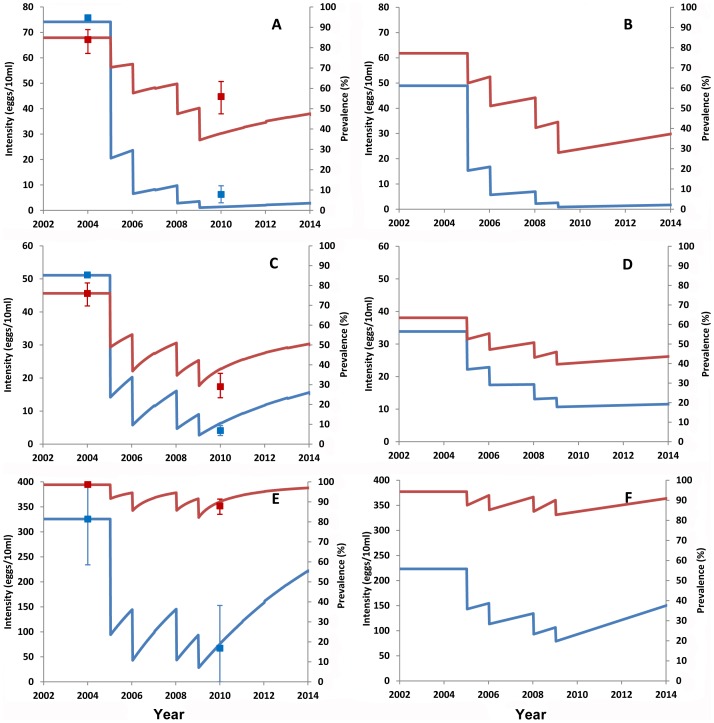
Comparison of the observed S. haematobium prevalence and intensity with the predicted changes.Prevalence is shown in red and intensity of infection is shown in blue. S. haematobium infection is shown in 7–14 year group (A, C and E) and in entire population (B, D and F). A and B: Macina district; B and C: San district; and E and F: Segou district. Lines show the predicted changes and squares in A, C and E show the observed results. Error bars represent the 95% CI.